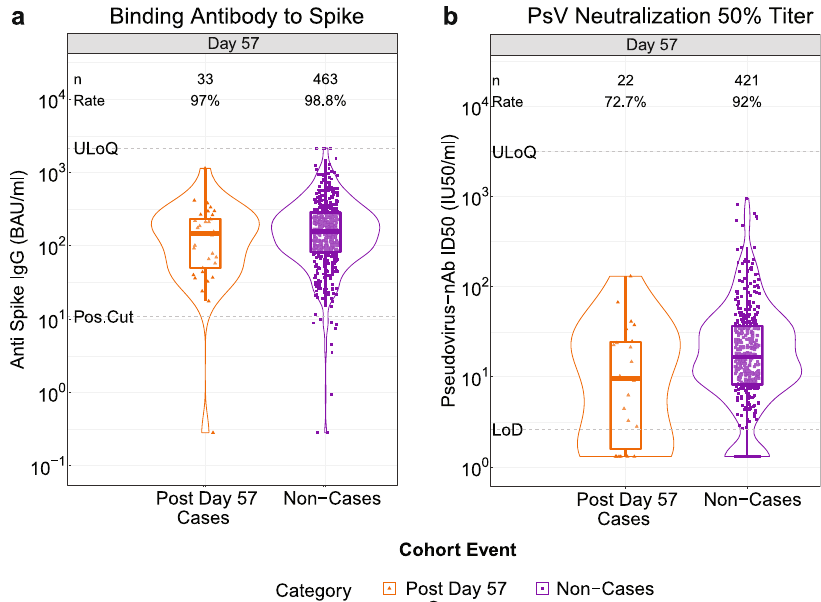
Fig. 1 D57 antibody marker level by COVID-19 outcome status in baseline SARS-CoV-2 negative vaccine recipients. a Anti-spike IgG concentration and b pseudovirus (PsV) neutralization ID50 titer. The violin plots contain interior box plots with upper and lower horizontal edges the 25th and 75th percentiles of antibody level and middle line the 50th percentile, and vertical bars the distance from the 25th (or 75th) percentile of antibody level and the minimum (or maximum) antibody level within the 25th (or 75th) percentile of antibody level minus (or plus) 1.5 times the interquartile range. At both sides of the box, a rotated probability density curve estimated by a kernel density estimator with a default Gaussian kernel is plotted. Frequencies of participants with positive spike IgG/detectable nAb ID50 responses were computed with inverse probability of sampling weighting (reported at the top of the plots as “ Rate ” ). Pos.Cut, Positivity cut-off for spike IgG de fi ned by IgG >10.8424 BAU/ml, the assay positivity cut-off. ULoQ = 6934 BAU/ml for spike IgG. Seroresponse for ID50 was de fi ned by a detectable value >limit of detection (LOD) (2.612 IU50/ml). ULoQ = 8319.938 IU50/ml. Post Day 57 cases experienced the primary COVID-19 endpoint starting 7 days post D57 visit through to the data cut (March 5, 2021). Non-cases are sampled into the immunogenicity subcohort with no evidence